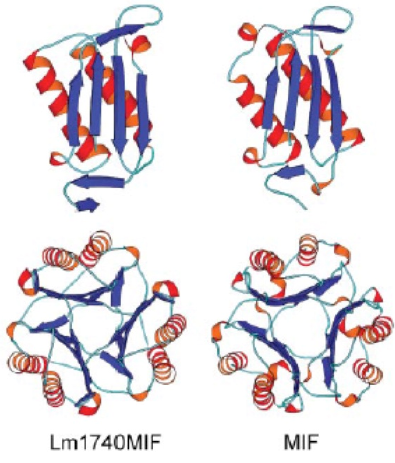
Figure 1. Schematic representation of Leishmania -encoded Lm 1740MIF and human migration inhibitory factor (MIF) with monomer above and trimer below. β-strands in blue, α-helices in red, random coils in cyan. Taken from Kamir et al . 2008 [30].